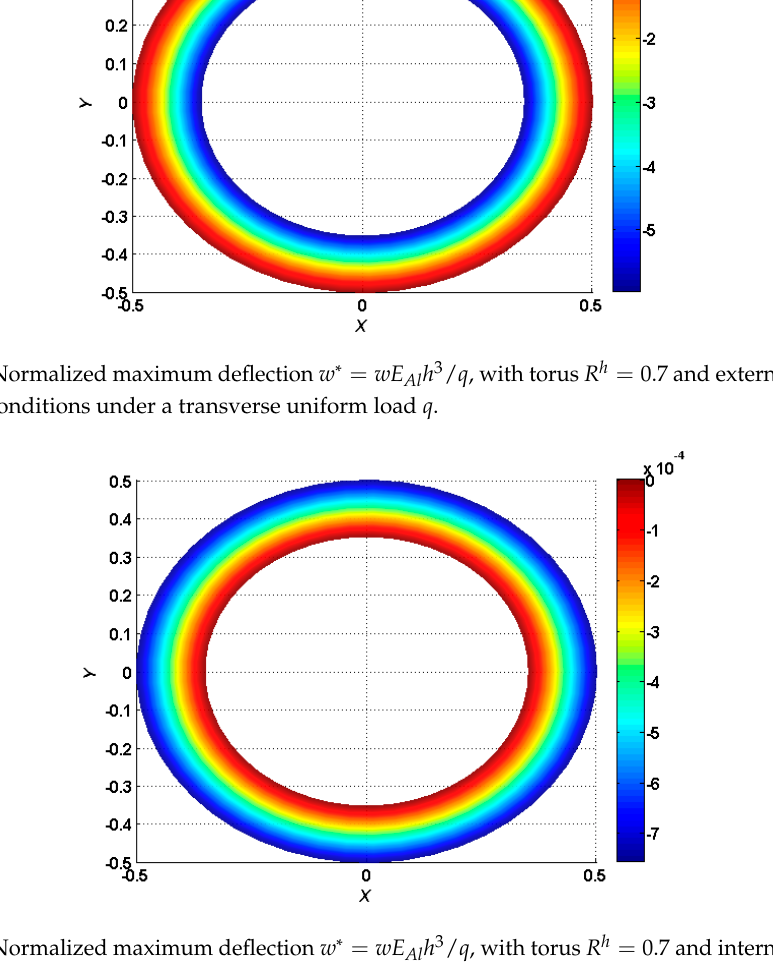
w wE h q = with torus 0.7 h R = and internal Al ,